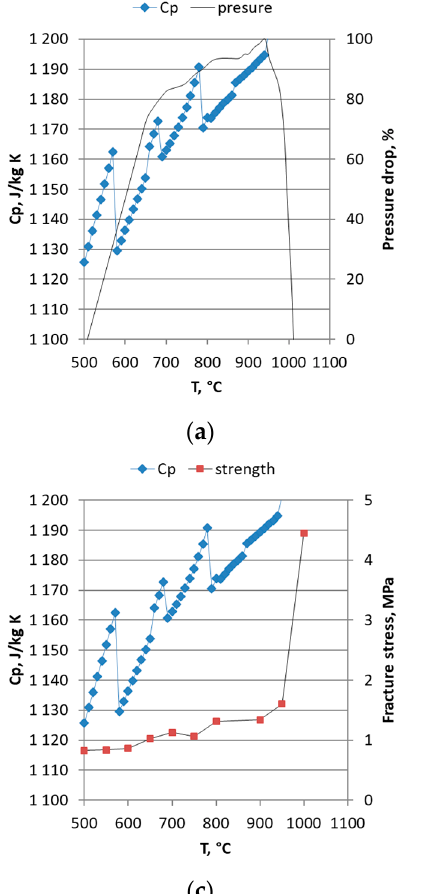
Figure 11. Lignite: ( a ) Specific heat (c p ) and pressure drop as a function of temperature; ( b ) density ( ρ )and pressure drop as a function of temperature; ( c ) specific heat and fracture stress as a function of temperature; ( d ) density and fracture stress as a function of temperature.